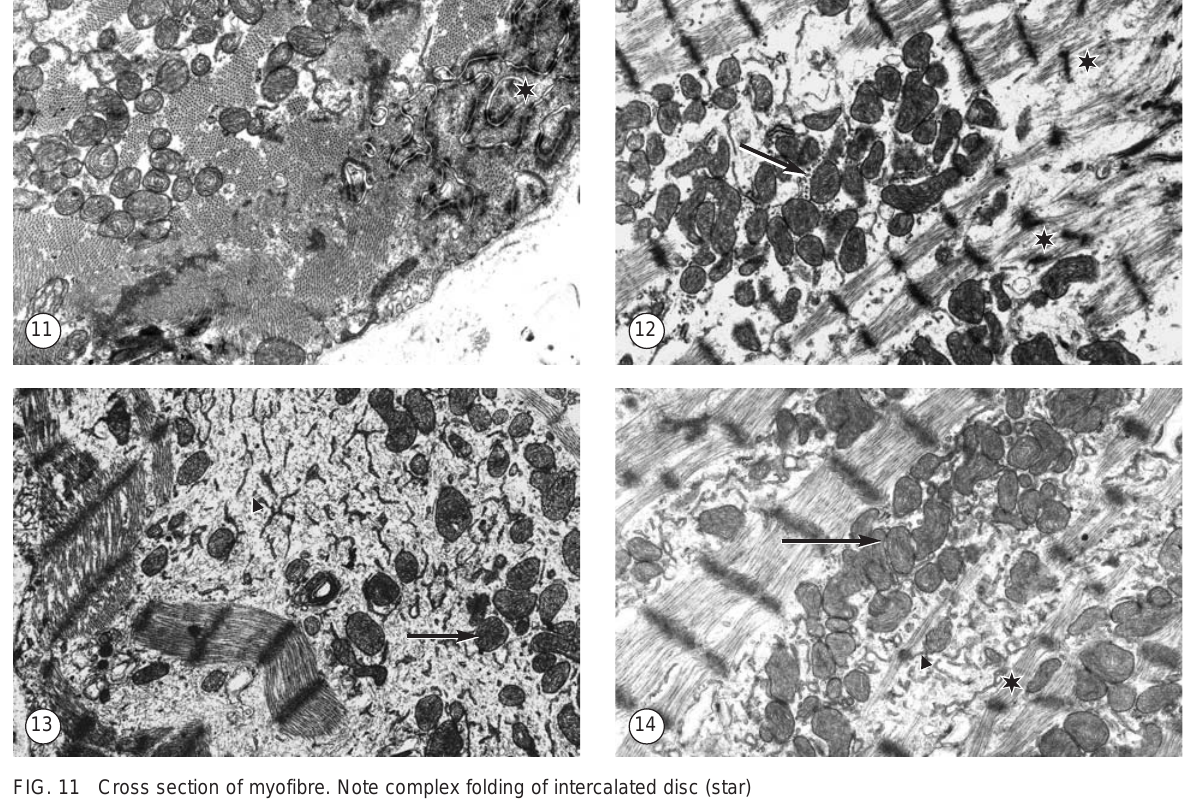
FIG. 11 Cross section of myofibre. Note complex folding of intercalated disc (star) FIG. 12 Myocardial cells with advanced myofibrillar loss were atrophic. Note streaking of Z-band material (star) and mitochondria proliferation (arrow) FIG. 13 Disintegrated myofibre. Note mitochondria (arrow) and sarcoplasmic reticulum proliferation (arrow head) FIG. 14 Myofibre with advanced myofibrillar loss due to myofilament disintegration (star). Note mitochondria proliferation (arrow) and sarcoplasmic reticulum proliferation (arrow